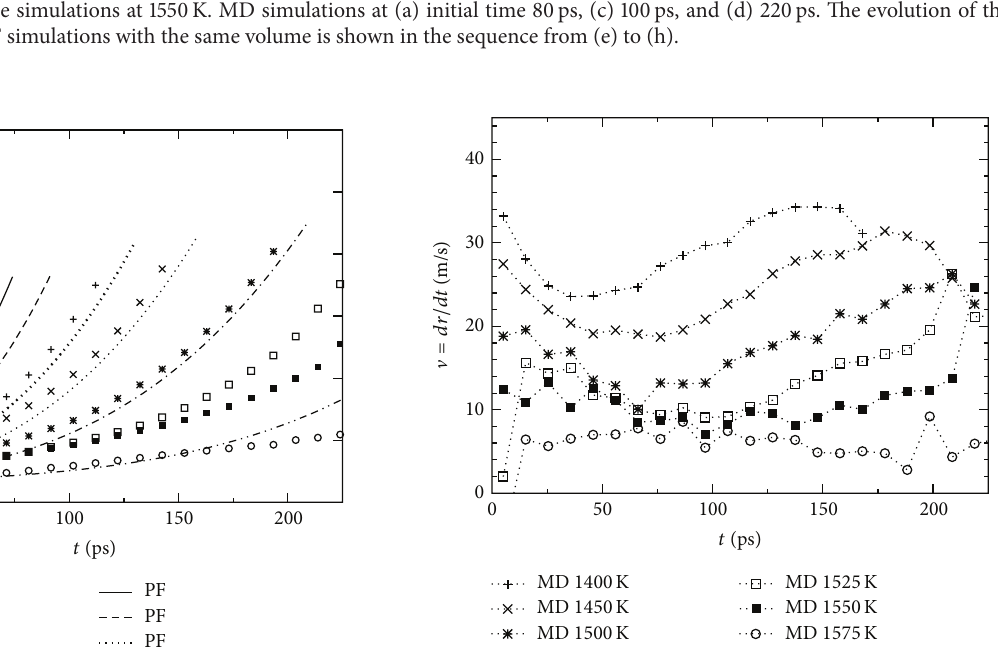
Figure 4: Evolution of the radial velocity at different temperatures obtained from MD